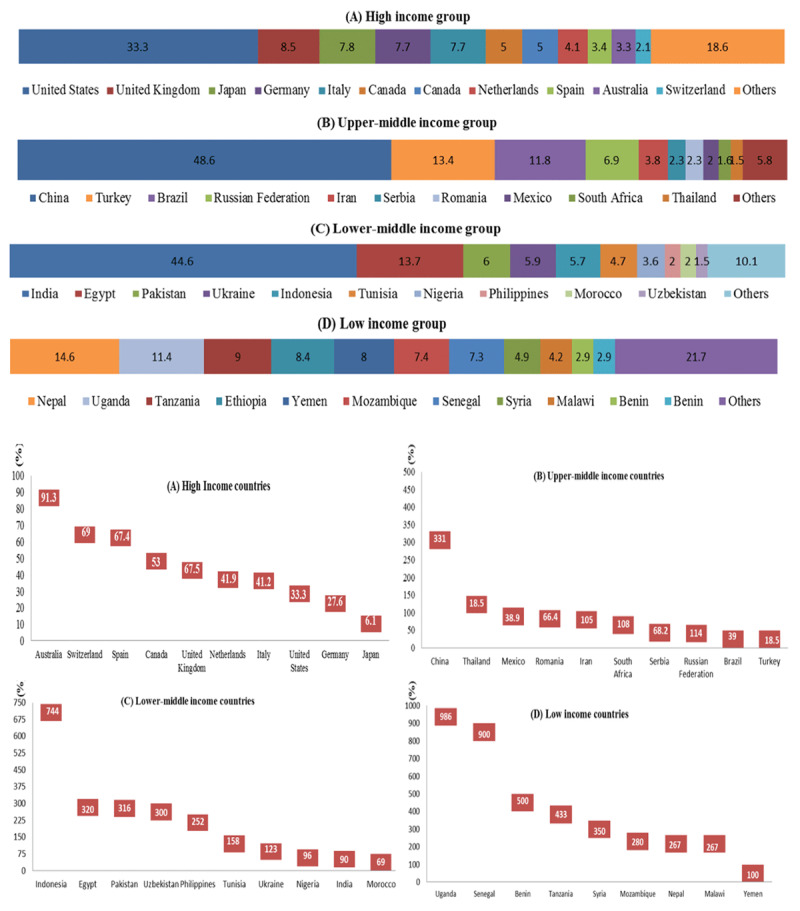
(i) Ranking of top 10 countries based on contribution to the 10-year cardiovascular research output of each income group. The width of the bar represents magnitude of contribution. Numbers for each country are its CV publications integer counts as a percentage of total CV publication integer counts of its income group. (ii) Percentage increase in integer counts of cardiovascular publications in top 10 countries based on contribution to total research output of each income group from 2008 to 2017.